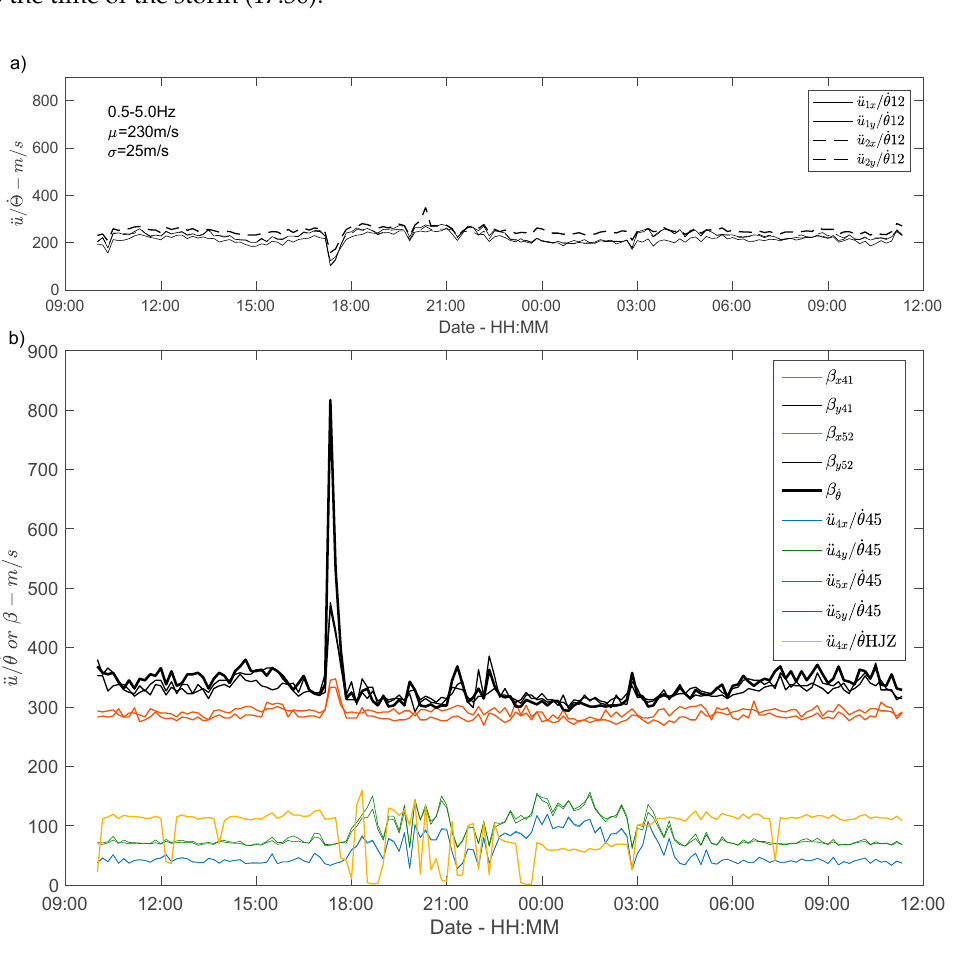
Figure 11. ( a ) Phase velocity variations calculated from the ratio between acceleration and array-derived rotation rate at the bottom of the structure; ( b ) Comparison of velocities calculated by SIbyD and derived from the ratios between acceleration and rotation at the top of the building.